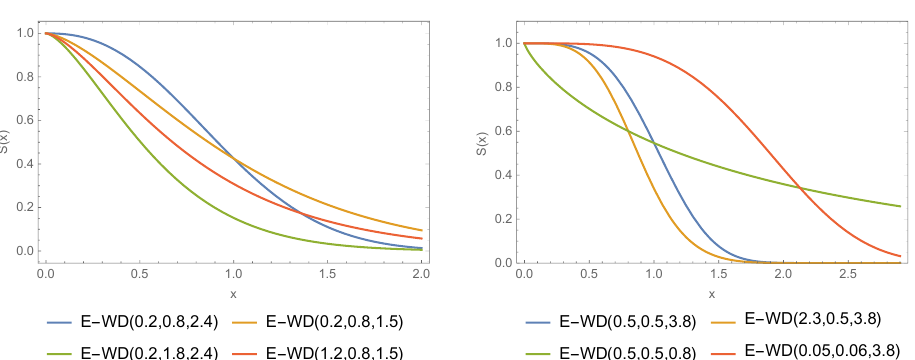
Figure 1. Different PDF for the E-WD.